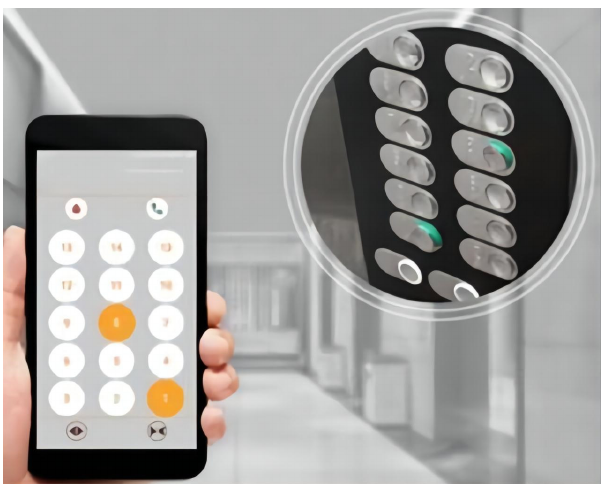
Figure 1. Gesture car calling.